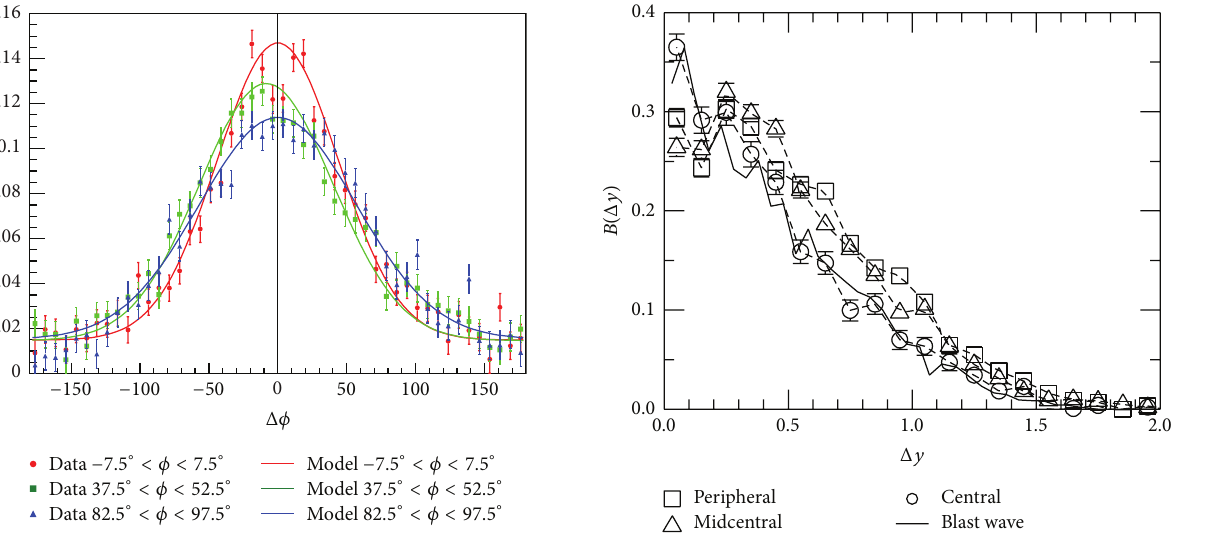
Figure 17: The balance functions from 200𝐴 GeV Au+Au collisions measured by STAR are compared to the canonical blast-wave model described in the text. The model should set a lower bound for the width of a balance function provided that the particles are emitted thermally. The remarkable agreement with the data suggests that charge conservation remains highly localized at breakup. The graph is taken from